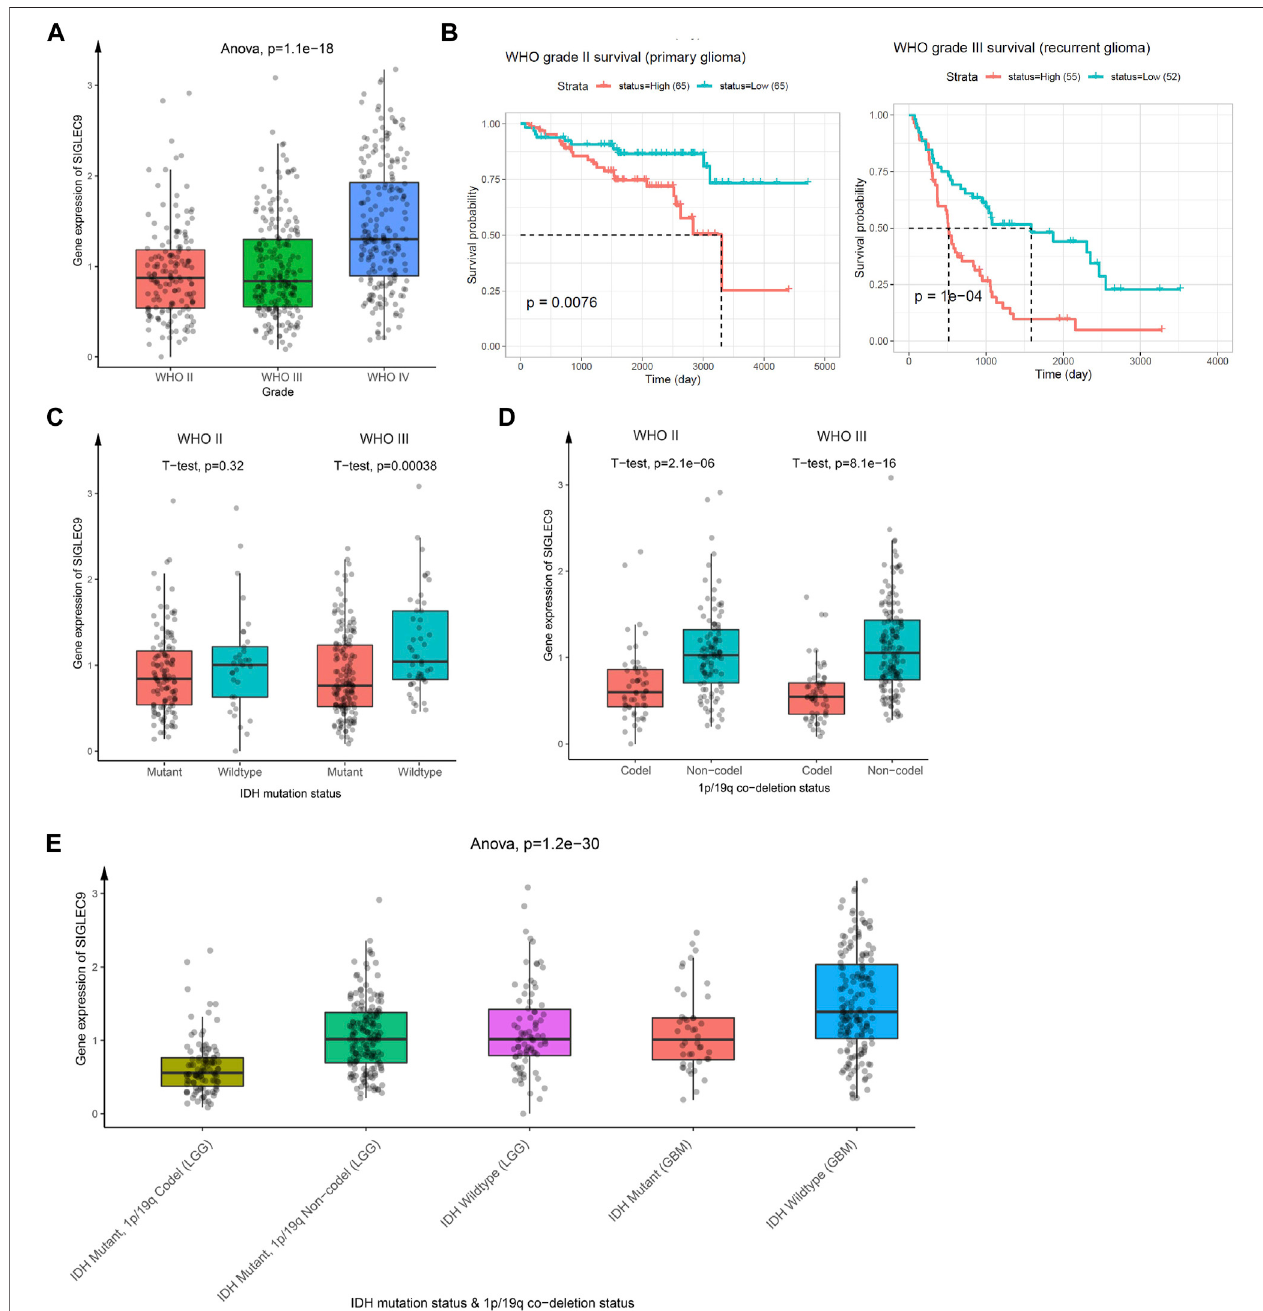
FIGURE 8 | The relationship between Siglec-9 mRNA expression and clinical characteristics in brain lower-grade glioma (LGG). (A) Siglec-9 mRNA expression in different glioma grades. (B) Expression of Siglec-9 was related to OS in WHO grade II (primary glioma) and WHO grade III (recurrent glioma). (C) Different Siglec-9 expression inWHOgradeIIandWHOgradeIIIdependedonIDHmutationstatus. (D) DifferentSiglec-9expression inWHOgradeIIandWHOgradeIIIdependedon1p/ 19q co-deletion status. (E) Different Siglec-9 expression in WHO grade II and WHO grade III depended on IDH mutation status combined with 1p/19q co-deletion status. (Statistical methods are shown in the fi gures. P < 0.05 was considered signi fi cant. IDH: isocitrate dehydrogenase.)